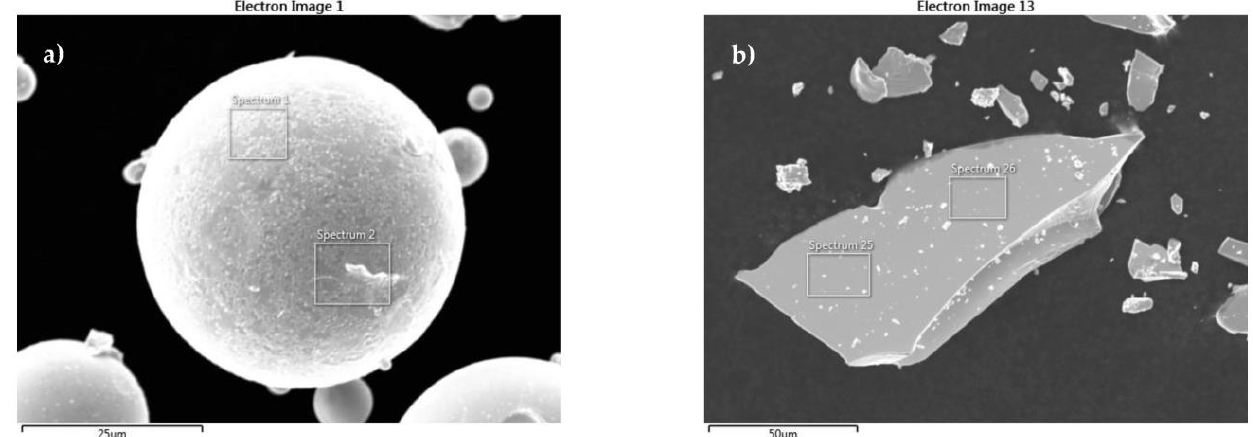
Figure 3. SEM micrographs of the as-received Mqp S particles ( a ) and Mqp B+ particles ( b ).